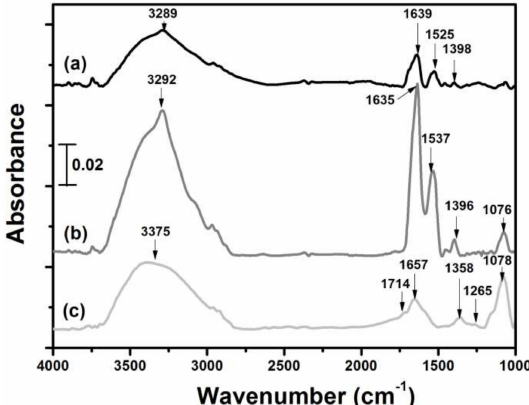
Figure 2. FTIR spectra of ( a ) pure OA, ( b ) a mixture of GO and OA (1:5 weight ratio), and ( c ) pure GO. The peak assignments of all the spectra are summarized in Table